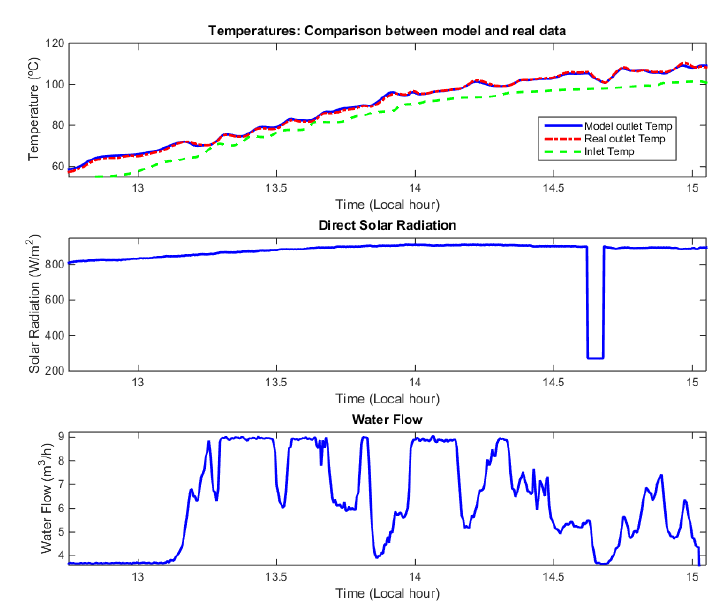
Figure 5. Solar field evolution Model vs Real: 31 July 2017.